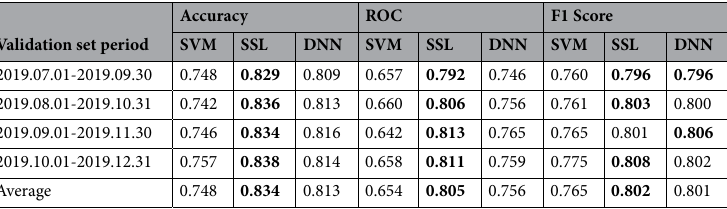
Table 2. Performance comparison using SVM, SSL, and DNN with training set using 3 months of data.